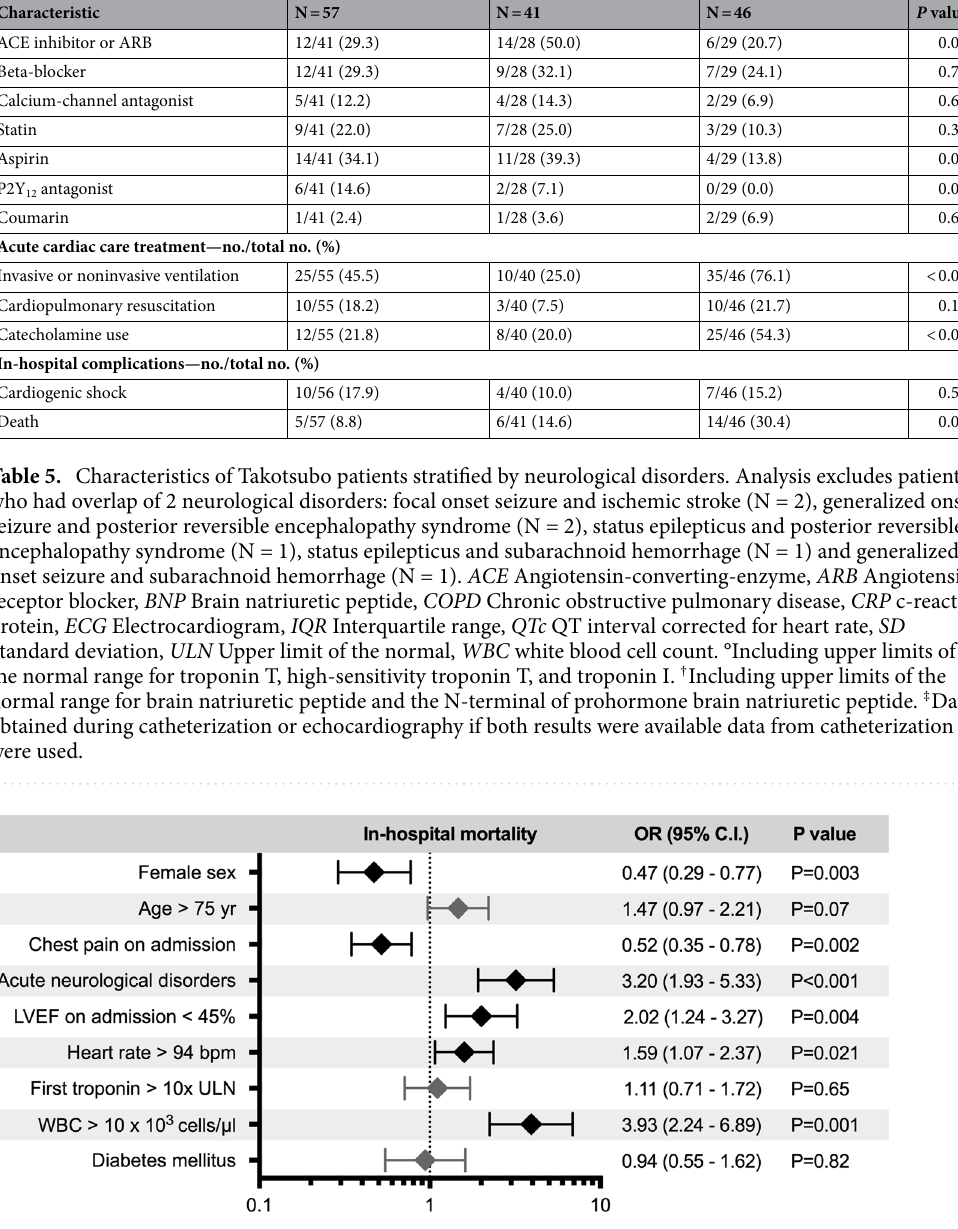
Figure 3. Factors associated with in-hospital mortality. Acute neurological disorders, left ventricular ejection fraction < 45%, heart rate over 94 bpm, and WBC > 10 × 10 3 cells/µ were identified as factors associated with in-hospital mortality. Bpm beats per minute; C.I. confidence interval; LVEF left ventricular ejection fraction; OR odds ratio; ULN upper limit of normal; WBC white blood cell count. Errors bars indicate 95% confidence intervals. Black indicates statistically significant variables, while grey is not